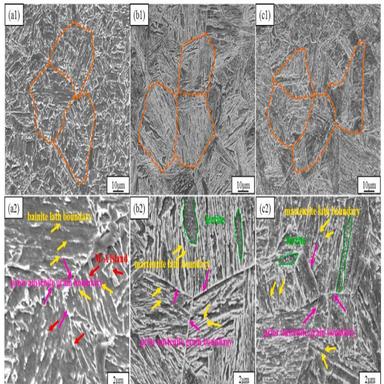
Metallographic microstructure of the three kinds of Ni advanced steel (a1) (a2) TMCP steel, (b1) (b2) DQ steel, (c1) (c2) QT steel.